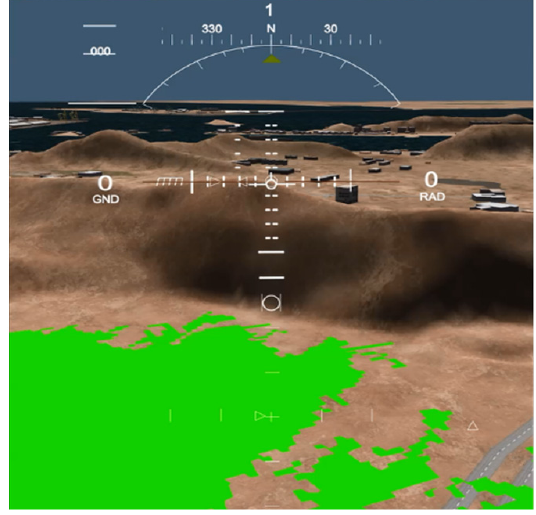
Figure 9. SLZs of Scene 3 projected on Vega Prime.